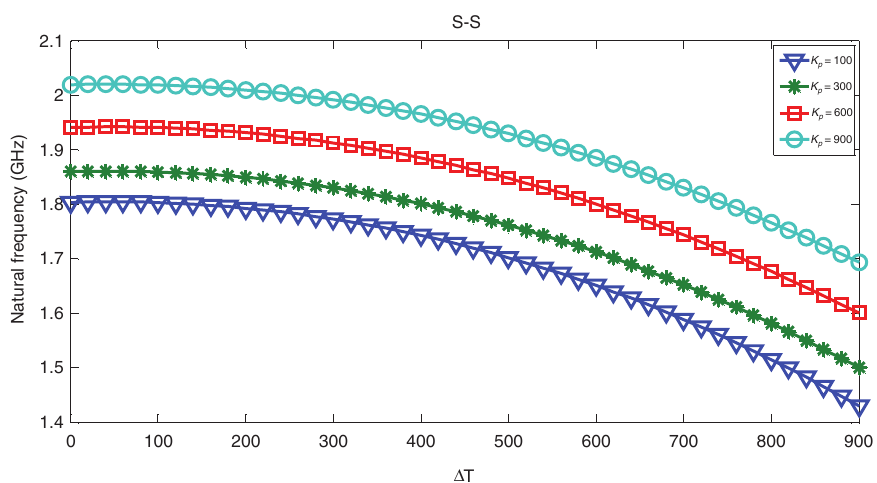
Figure 11: The effect of Pasternak stiffness on the natural frequency with simply-simply boundary